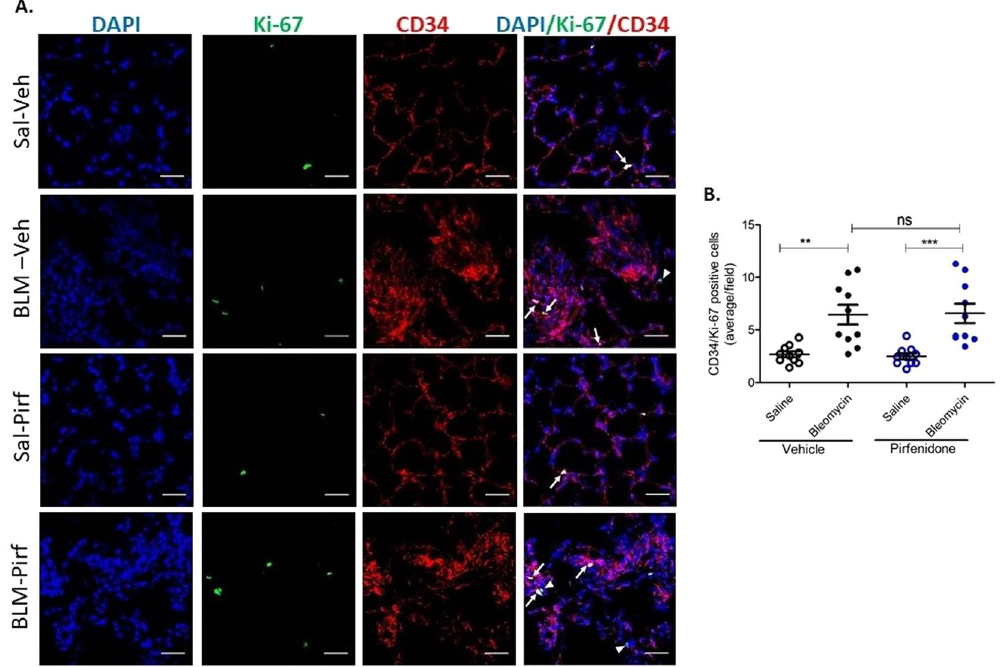
Figure 6. Pirfenidone does not reduce alveolar capillary endothelial proliferation in vivo . ( A ) Representative immunofluorescence photomicrograph of lung cryosections from differentially treated lung segments double stained with Ki-67 and CD34 antibodies. CD34 stained vessels together with Ki-67 signals indicate endothelial cell proliferation (arrows indicate Ki-67 overlapping with CD34 immunofluuorescence). Arrowheads indicate proliferating non-endothelial cells. ( B ) Shows data for CD34/Ki-67 positive cells from the different treatment groups (average/10 fields in each differentially treated segments, n = 10 sheep), ** p < 0.01, *** p < 0.001, ns-not significant. Data represent mean ( ± SEM). Sal-Veh = saline-vehicle lobe; BLM-Veh = bleomycin-vehicle lobe; Sal-Pirf = saline-pirfenidone lobe; BLM-Pirf = bleomycin-pirfenidone lobe. Scale bars = 50 µ